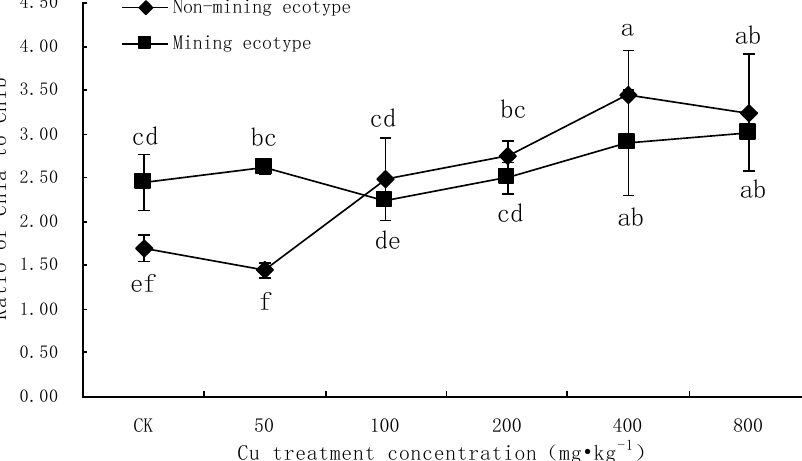
Figure 1. Chlorophyll a/b of two ecotypes of M. floridulus under different Cu treatment. Note: Error bars indicate standard deviation; different letters in the same group indicate significant difference at p < 0.05 according to Duncan’s multiple range tests; the same below.